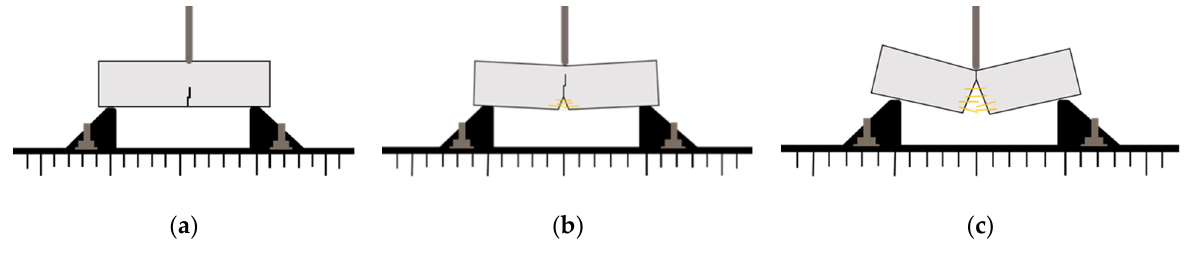
Figure 9. Specimens after flexural failure.